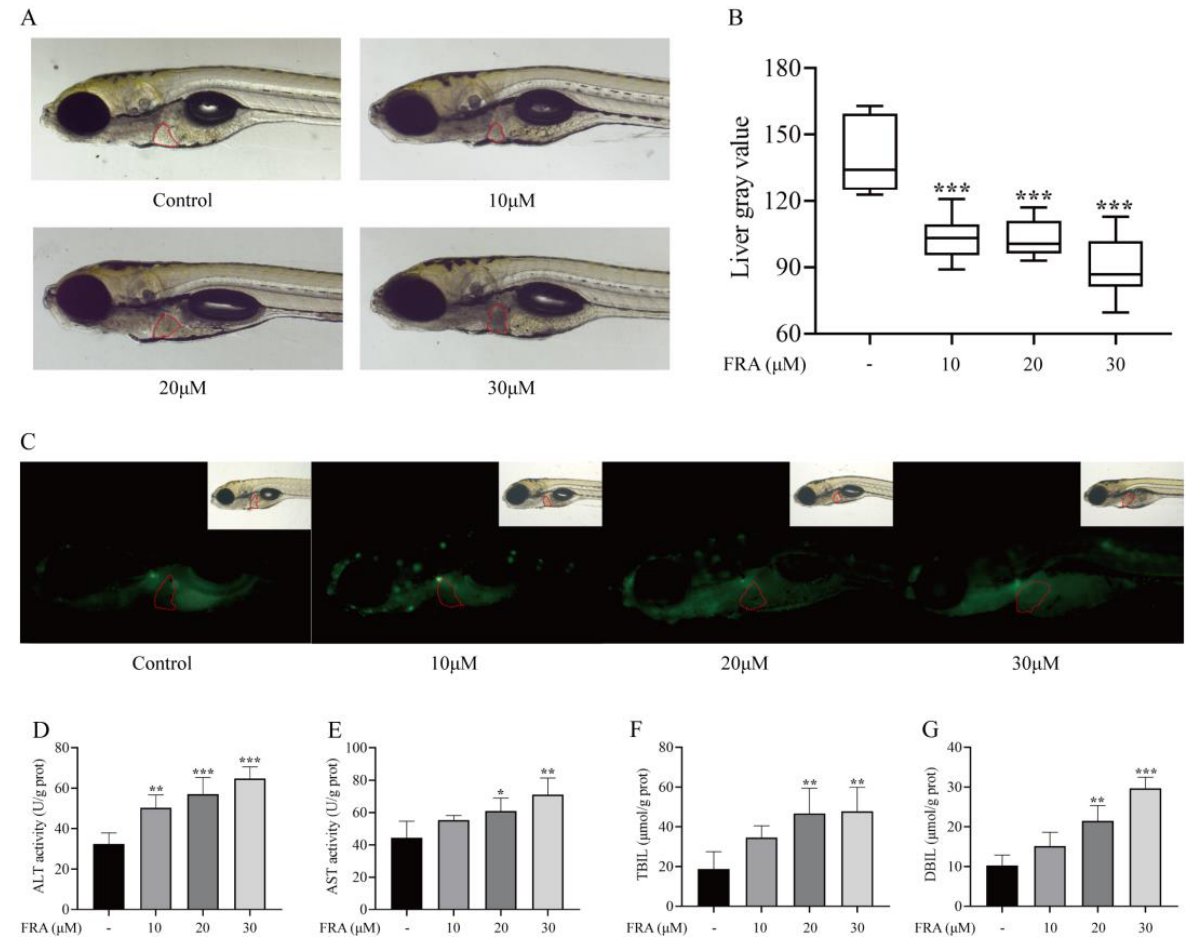
Figure 2. Hepatotoxic effects of FRA on zebrafish larvae. Treatment with different concentrations of